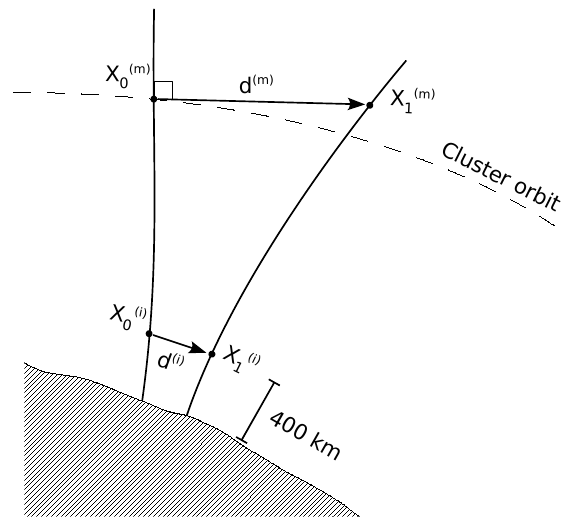
Fig. 4. Illustration of the mapping procedure. The measured convection velocity at location x ( m ) is converted into a spatial vector d ( m ) by multiplying with a scaling factor. The endpoints of this vector, x ( m ) and x (m) are then mapped into the ionosphere, based upon the Tsyganenko T2001 model, where the corresponding ionospheric convection velocity is then obtained from the mapped vector d ( i ) . The scales are exaggerated for clarity.